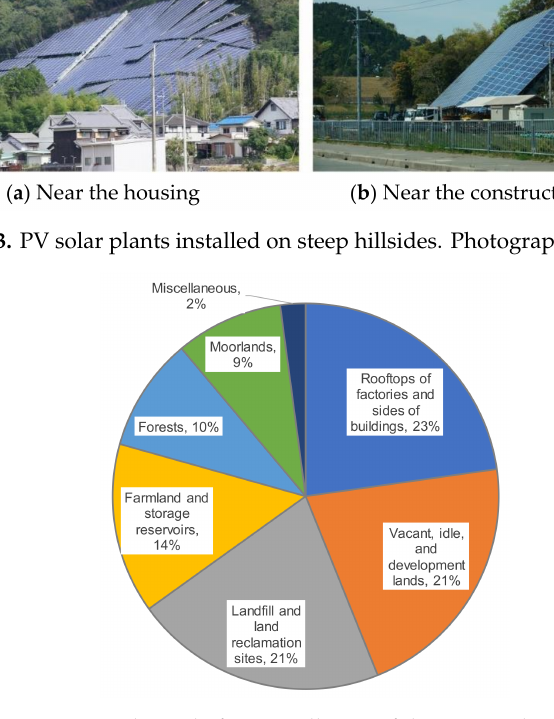
Figure 4. Land uses before installation of the mega solar plants.